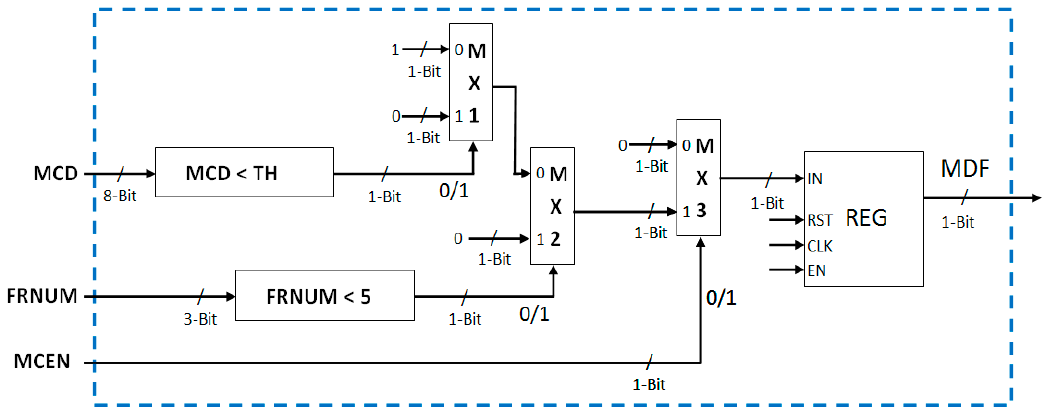
Figure 16. Architecture of motion detection flag computation module.